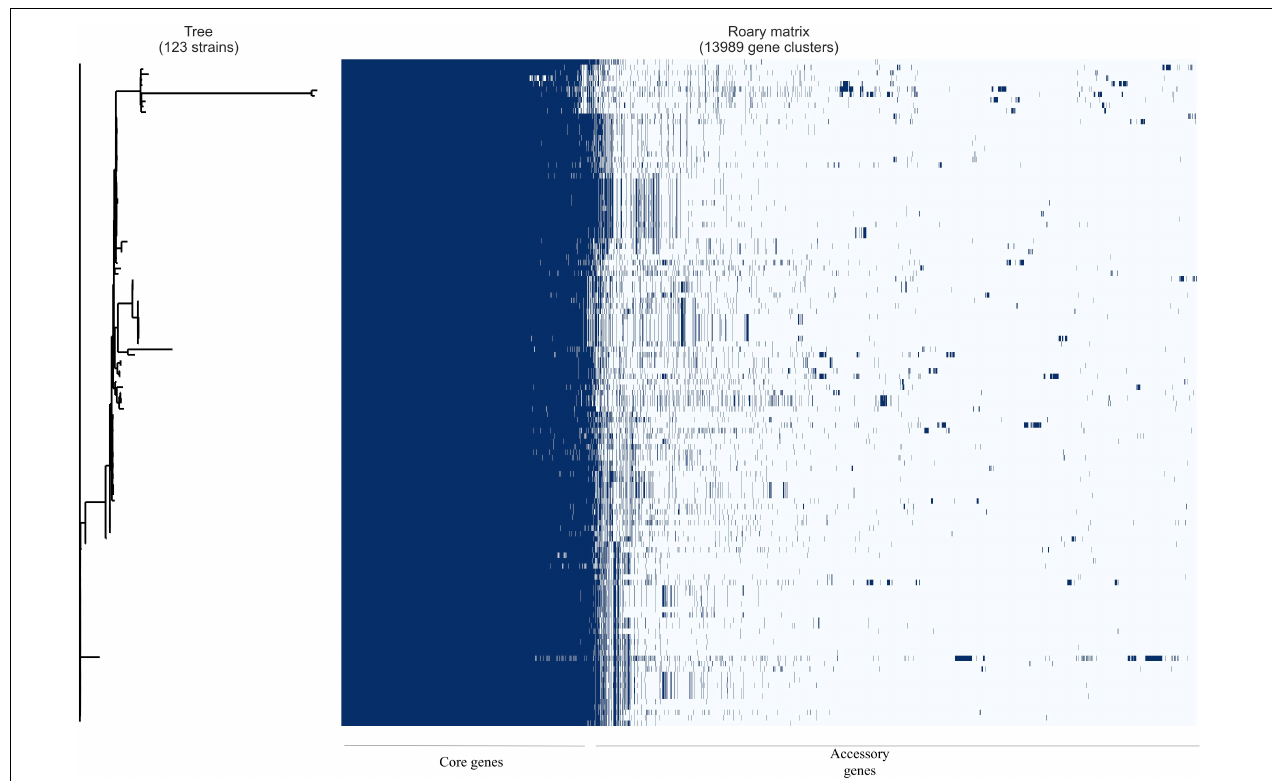
FIGURE 2 | Gene presence/absence matrix from pangenome analysis of 123 E. coli isolates with Roary and roary.plots. Each row shows gene profile of each isolate.